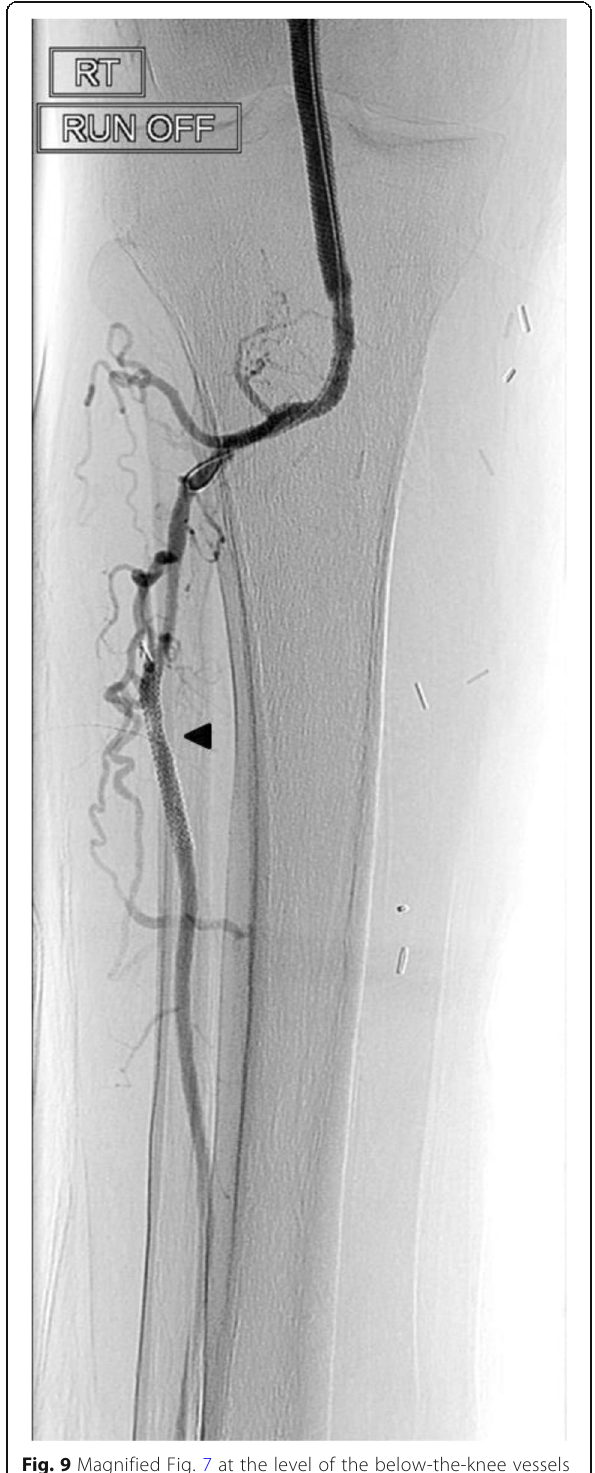
Fig. 9 Magnified Fig. 7 at the level of the below-the-knee vessels where the occluded segment of the anterior tibial artery has been recanalized and stented (arrow head) also popliteal artery with a